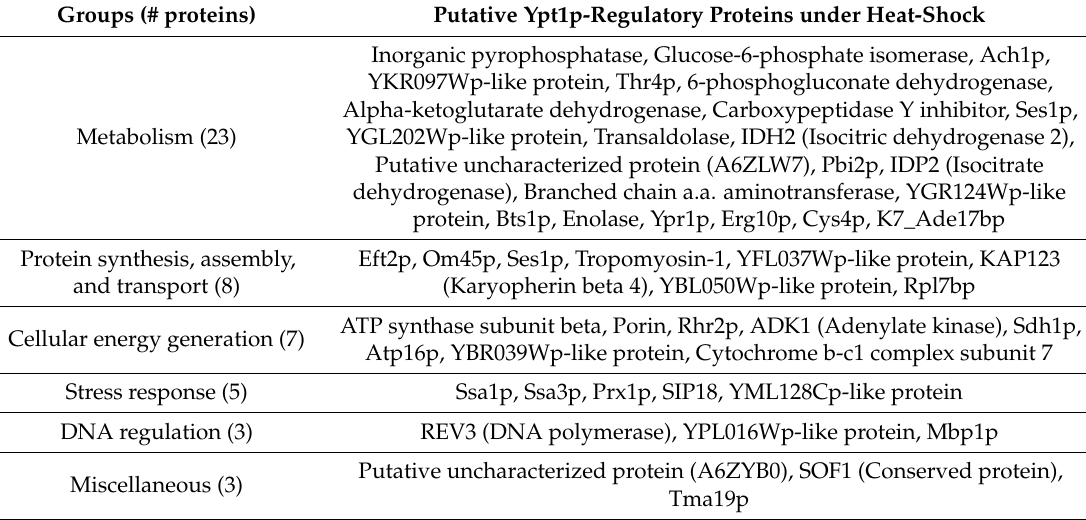
Table 1. Categorized Lists of Putative Ypt1p-Regulatory Proteins under Heat-Shock. See Table S1 for further details. “# proteins” means number of proteins in the